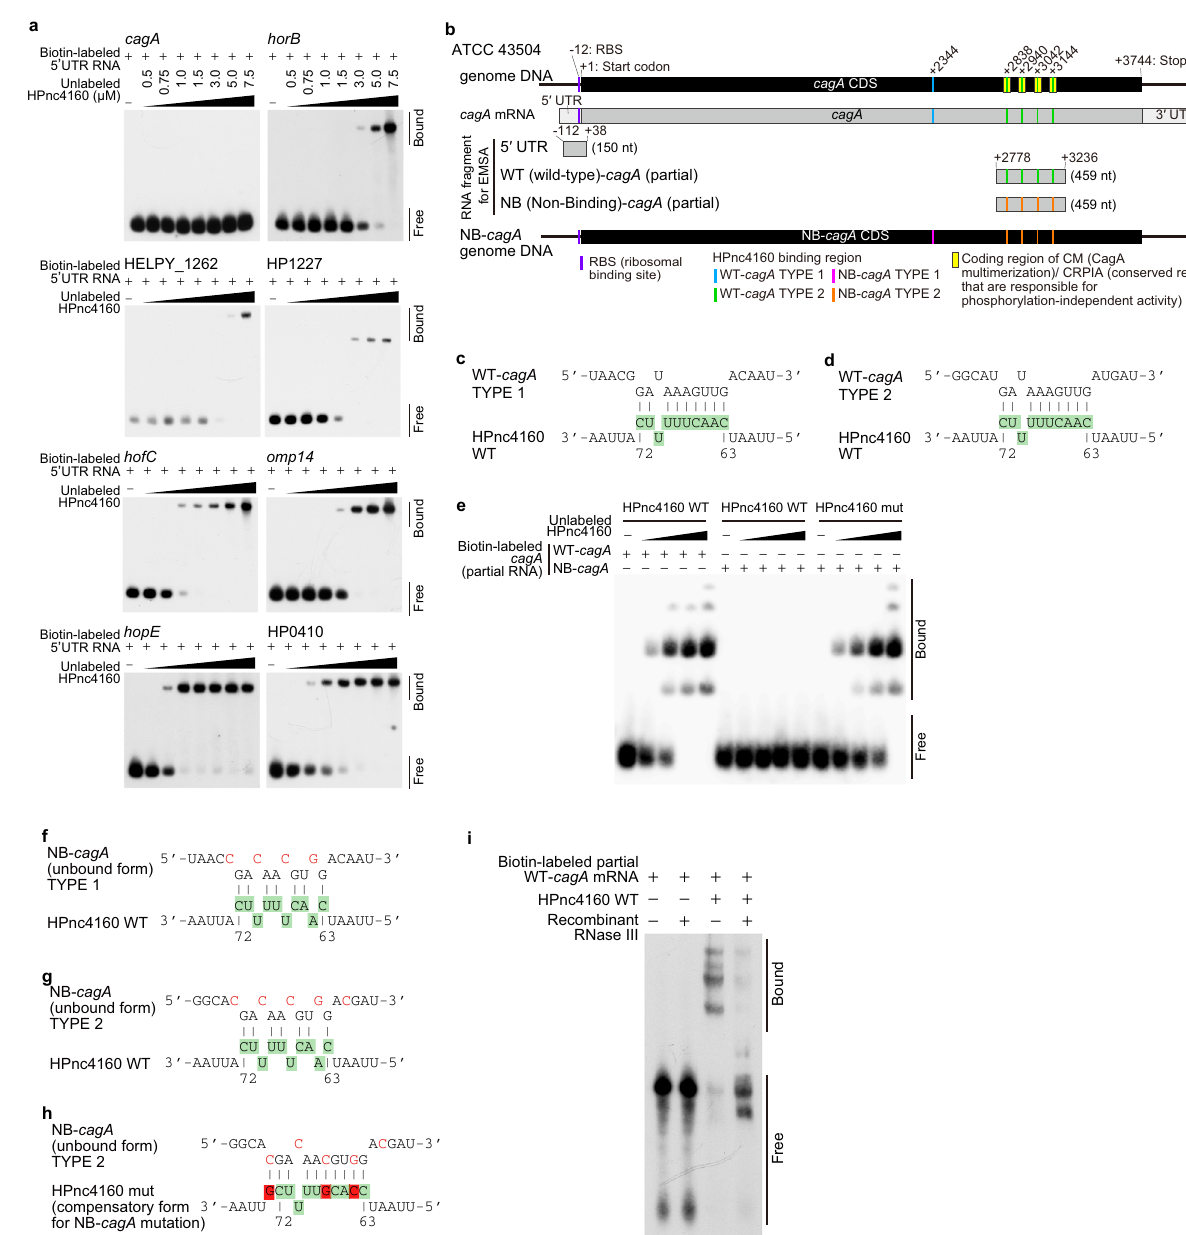
Fig. 3 HPnc4160 binds to target mRNA. a Electrophoretic mobility shift assay (EMSA) analysis of HPnc4160 binding to the 5 ′ UTR region of each candidate mRNA. Data are representative of two independent experiments. b Schematic of CagA motifs, HPnc4160 binding regions, and HPnc4160-non- binding cagA (NB- cagA ). c , d Schematic of predicted HPnc4160 binding sites in the corresponding CDS sequence of cagA TYPE 1 ( c ) and TYPE 2 ( d ). Upper sequences indicate target cagA mRNA sequences; lower sequences indicate the HPnc4160 sequence with base numbers. Colored sequences correspond to the loop structures indicated in Supplementary Fig. 4a. e EMSA analysis of HPnc4160 WT or HPnc4160 mut (a compensatory form of NB- cagA ) bindings to RNA of partial cagA WT or NB- cagA . Data are representative of two independent experiments. f – h Schematic of CDS sequence of the NB- cagA of TYPE 1 ( f ) and TYPE 2 ( g ) and HPnc4160 mut ( h ). Upper sequences indicate target cagA mRNA sequences; lower sequences indicate the HPnc4160 sequence with base numbers. Green-colored sequences correspond to the loop structures of HPnc4160 indicated in Supplementary Fig. 4a. Mutated nucleotides in the cagA mRNA sequence are shown in red. Red-colored sequence correspond to mutated nucleotides in the hpnc4160 sequence ( h ). i RNase protection assay with HPnc4160, cagA mRNA, and recombinant RNase III. Data are representative of two independent experiments. Source data are provided as a Source Data fi IL-8 in AGS cells infected with the T-repeat mutated strains (Supplementary Fig. 5j).